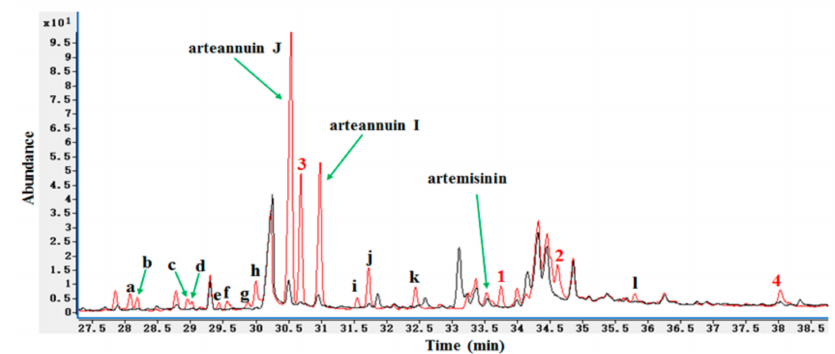
Figure 2. GC-MS detection of new products in cultured cells of A. annua. Black curve: The medium extract of A. annua cultured cells without the treatment of arteannuin I/J; Red curve: The medium extract of A. annua cultured cells with the treatment of arteannuin I/J; a – l : 12 unknown new peaks.